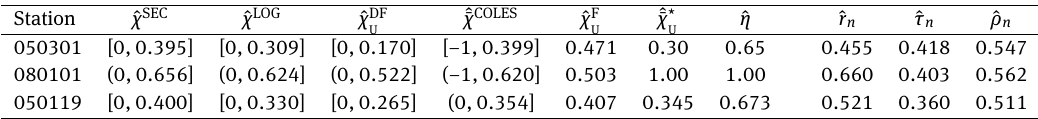
Table 2: Couple ( Q , V ) . Estimated tail dependence measures ˆ χ SEC , ˆ χ LOG , ˆ χ DF Estimated overall correlation coefficients ˆ r n , ˆ τ n and ˆ ρ n .